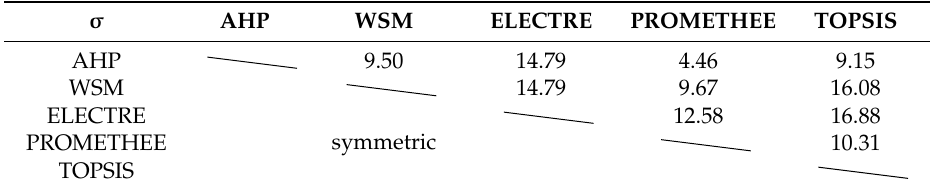
Table 8. Standard deviation σ of the integrated ranking between the different used